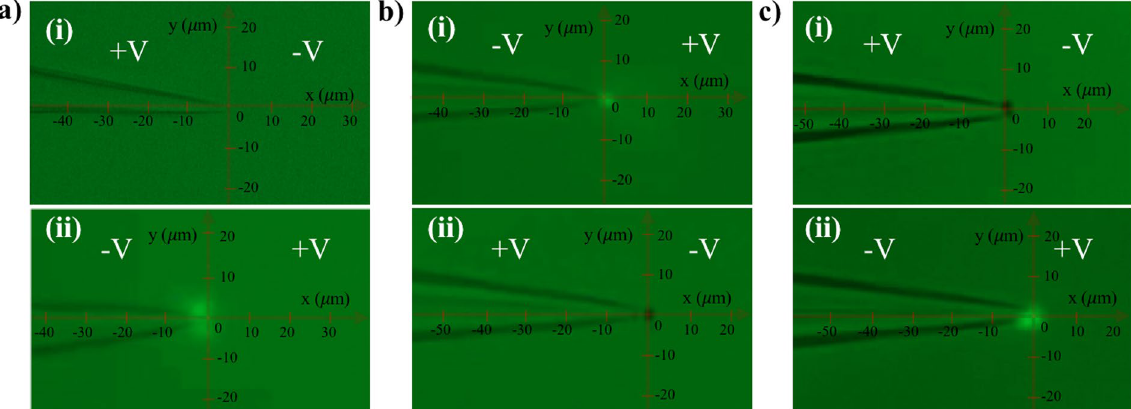
Figure 7. ( a ) Entrapment of 100 nm fluorescently-tagged liposomes suspeneded in the PBS solution using a 1 μ m pipette and 10 V/cm applied E-field. (i) The results after 100 seconds of applied positive bias at the base. (ii) The results after 100 seconds of applied negative bias at the base. ( b ) Selective entrapment of 100 nm flourescently-tagged liposomes and 510 nm non-fluorescent COOH-PS beads suspended in the PBS solution. (i) The results after 100 seconds of applied negative bias at the base of the pipette. (ii) The results after 100 seconds of the voltage polarity reversal to positive bias at the base. ( c ) Selective entrapment of 100 nm fluorescently- tagged liposomes and 510 nm non-fluorescent COOH-PS beads suspended in PBS solution. (i) The results after 100 seconds of applied positive bias at the base of the pipette. (ii) The results after 100 seconds of the voltage polarity reversal to negative bias at the base.